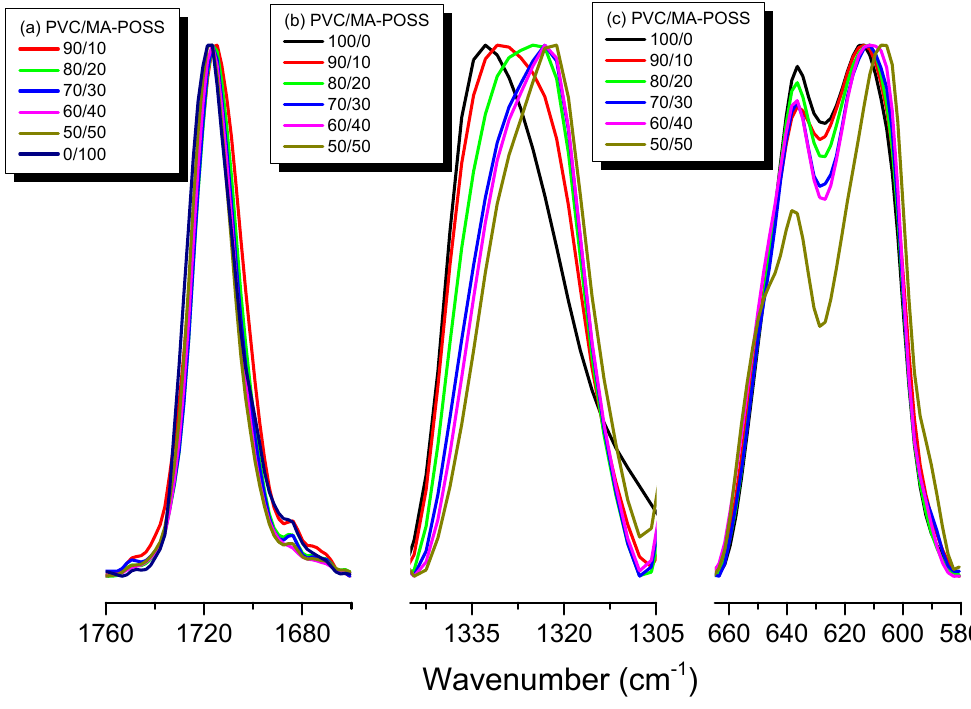
Figure 4. FTIR spectral analyses of the ( a ) C=O groups of MA-POSS, ( b ) C–H deformation of the CH 2 units of the PVC, and ( c ) C–Cl stretching vibration of the PVC, for various PVC/MA-POSS blends recorded at room temperature.